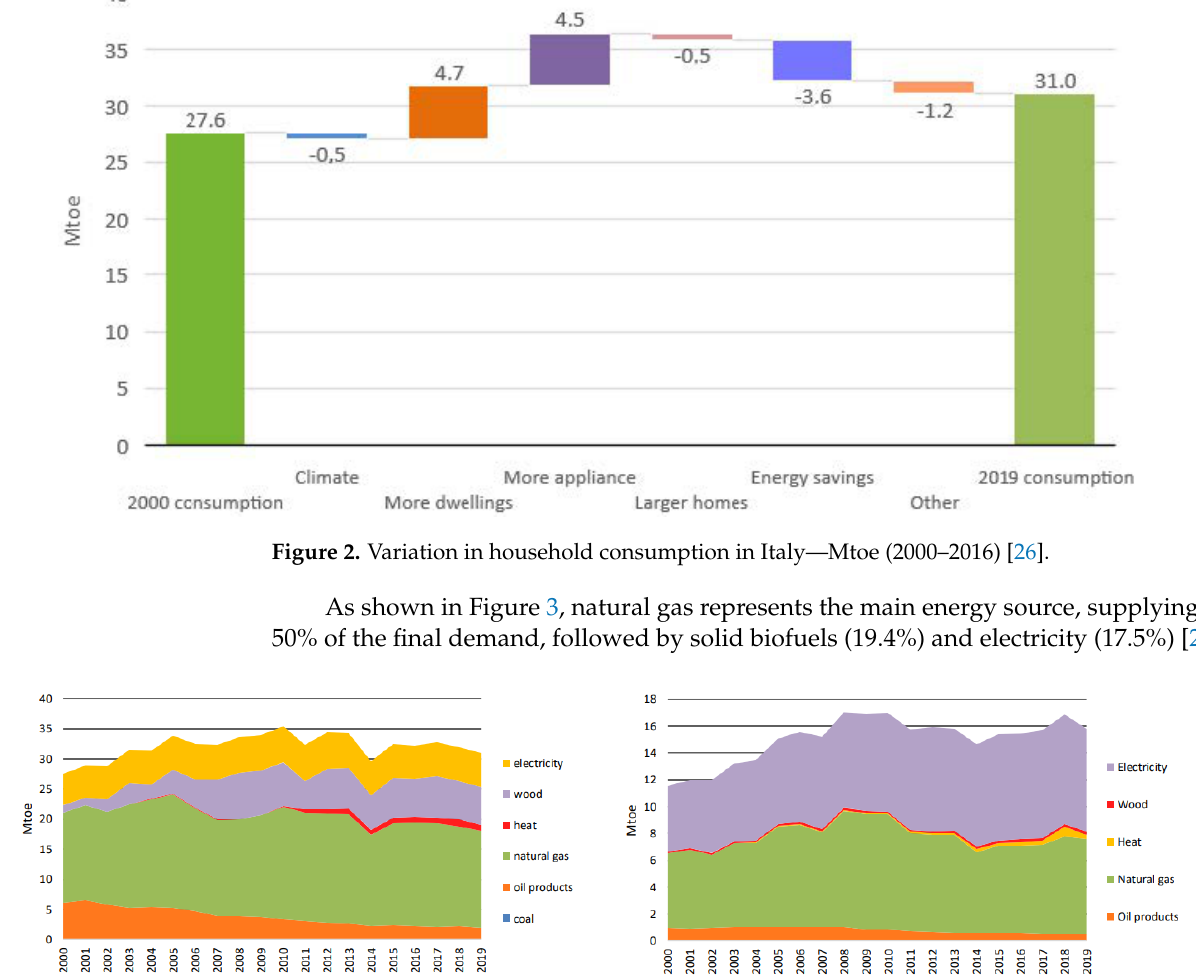
Figure 2. Variation in household consumption in Italy — Mtoe (2000 – 2016) [26].